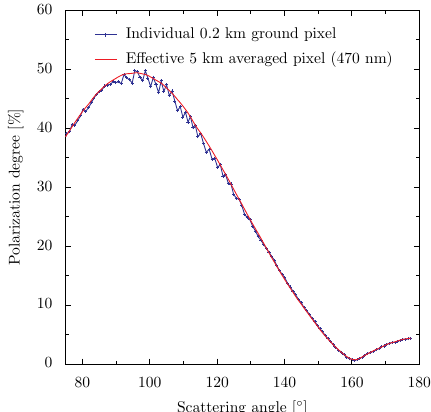
Figure 1. Measurements of individual ground pixel and effective 5km averaged pixel at 470nm. Oscillations in angular measure- ments are due to imperfect co-registration of different viewing an-